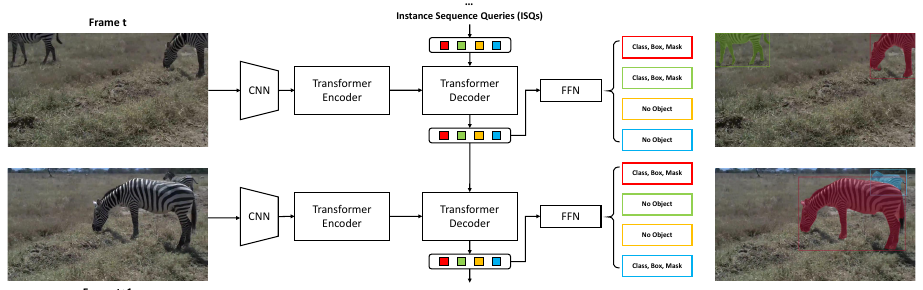
Figure 1. Architecture of our method. The transformer decoder uses ISQs as a clue for capturing similar instances at frame t. Meanwhile, the decoder outputs are adjusted based on the instances’ best appearances and become the input queries for the next